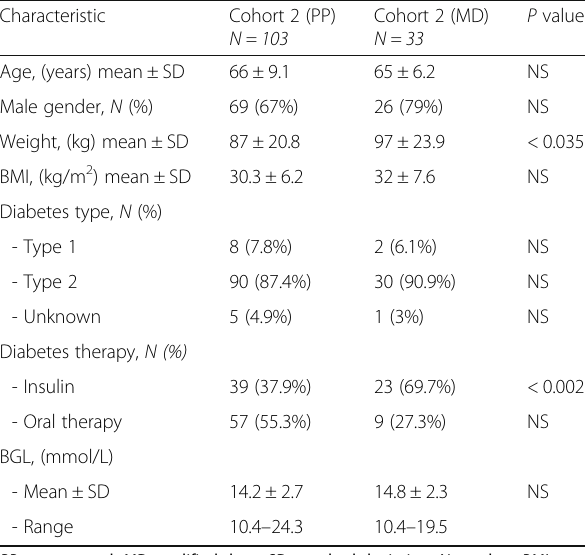
Table 2 Baseline characteristics comparison within Cohort 2 (PP vs MD